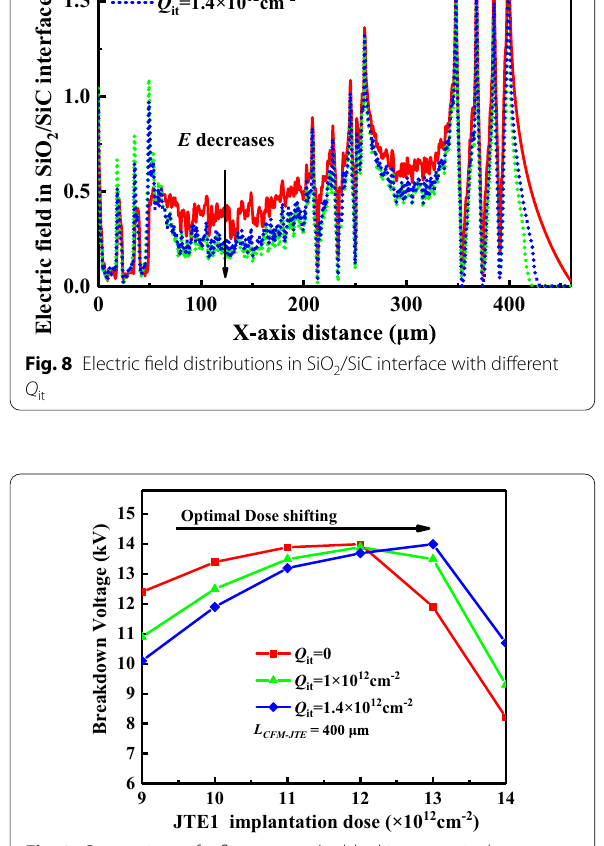
Fig. 9 Comparison of influences to the blocking capacity